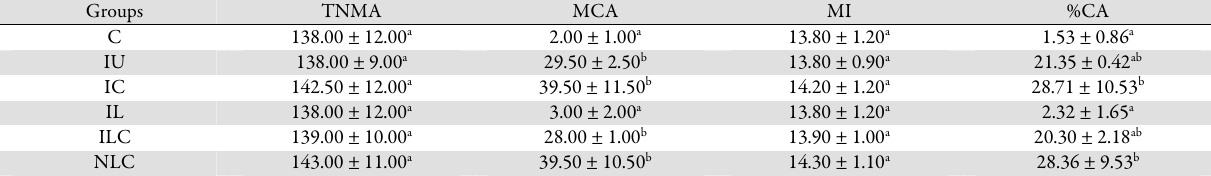
Table 10. Effect of lumefantrine and lumefantrine - copper complex on chromosomal aberration in the liver of P. berghei NK-65 infected mice